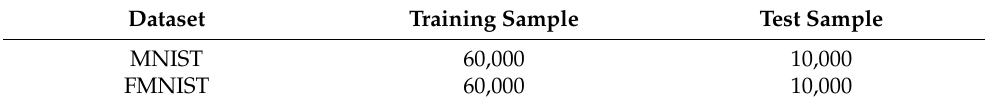
Table 1. Datasets used for FL in this study.